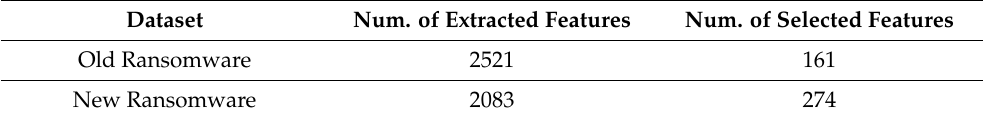
Table 5. The distribution of extracted and selected features for old and new ransomware APKs. Dataset Num. of Extracted